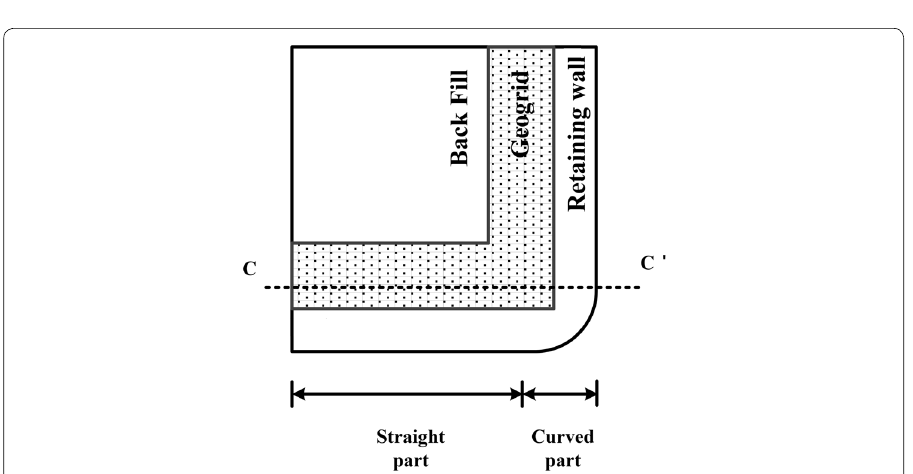
Vertical displacements and ground surface